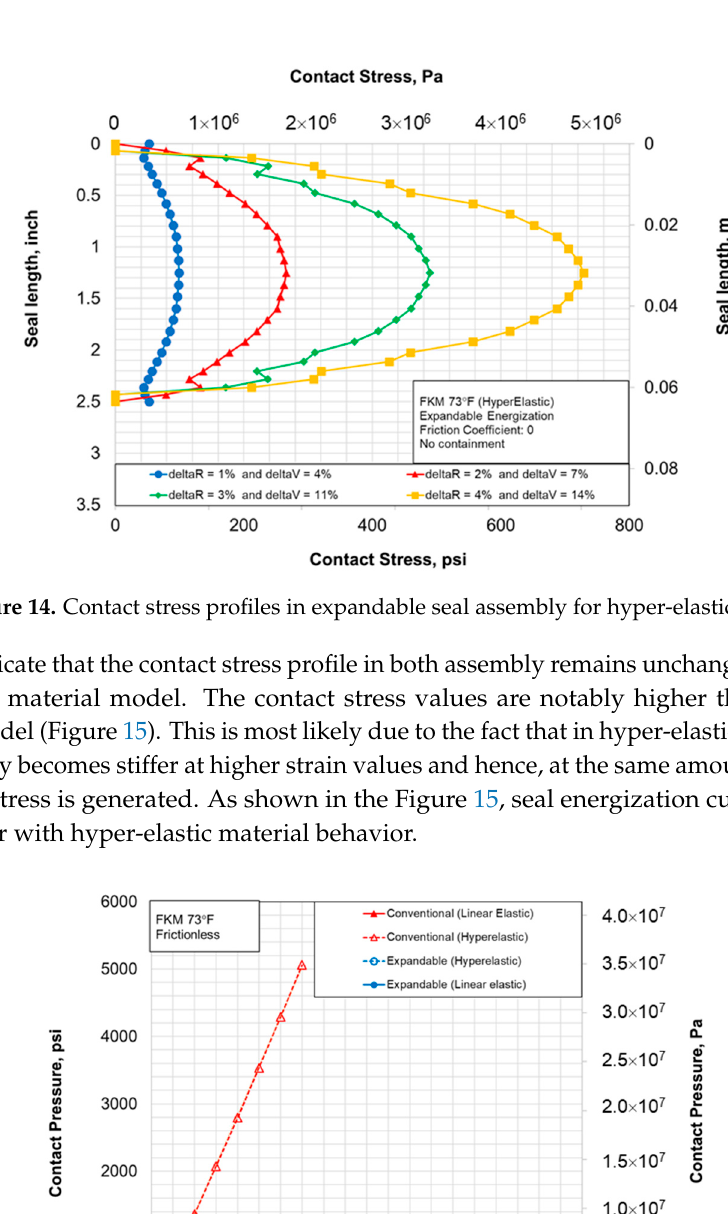
Figure 13. Contact stress profiles in conventional seal assembly for hyper-elastic FKM.